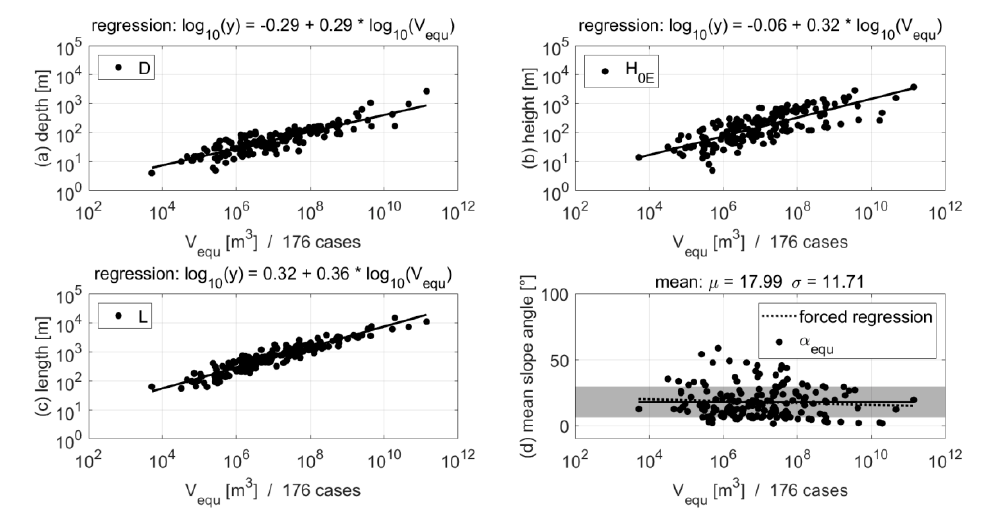
Figure 7. Examples of volume to parameter correlations for the set “full”. Dimension-related parameters (D ( a ), H 0E ( b ), and L ( c )) are approximated by a regression; for the shape-related parameter ( α equ ( d )), the mean value ( µ ) is calculated. The shading indicates the symmetric belts of two standard deviations ( ± 1 σ ) around the mean value ( µ ); the latter is very similar to the “forced” regression (regression parameters in Table 3).